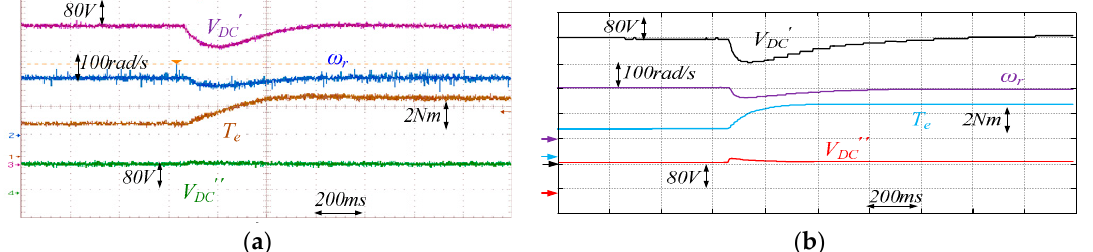
Figure 25. Load transient from T L = 2 Nm to T L = 4 Nm at ω r = 200 rad/s and V DC ' = 400 V, V DC '' = 100 V. Output voltage V DC ' , TLI DC bus voltage V DC '' , rotor speed ω r , electromagnetic torque T e . ( a ) Experimental results. ( b ) Simulation results.